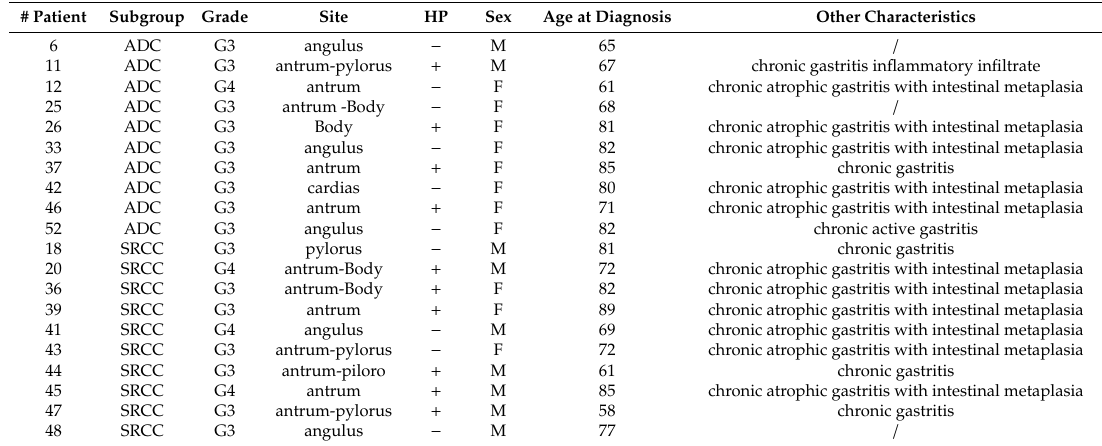
Table 2. Summary of the patients’